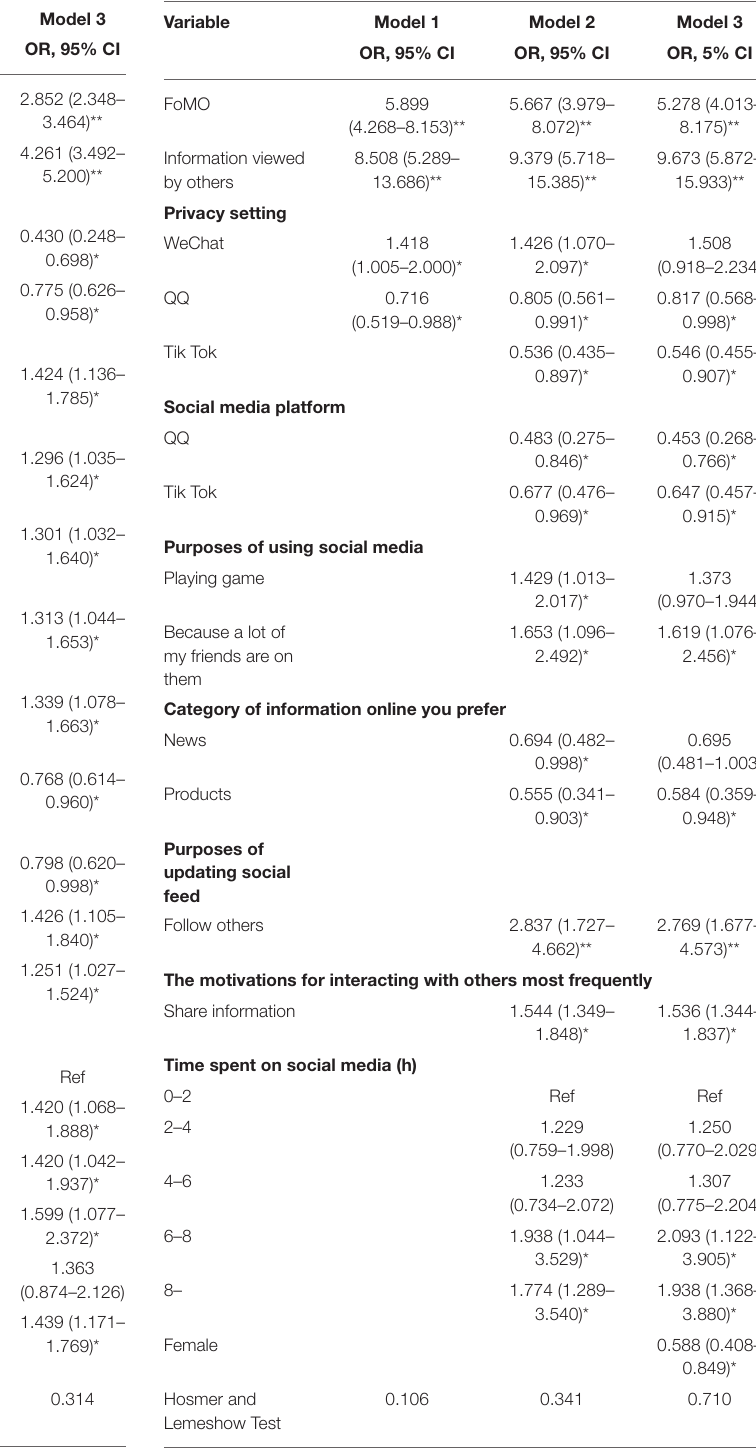
TABLE 3 | Factors associated with basic information shown on social media among university